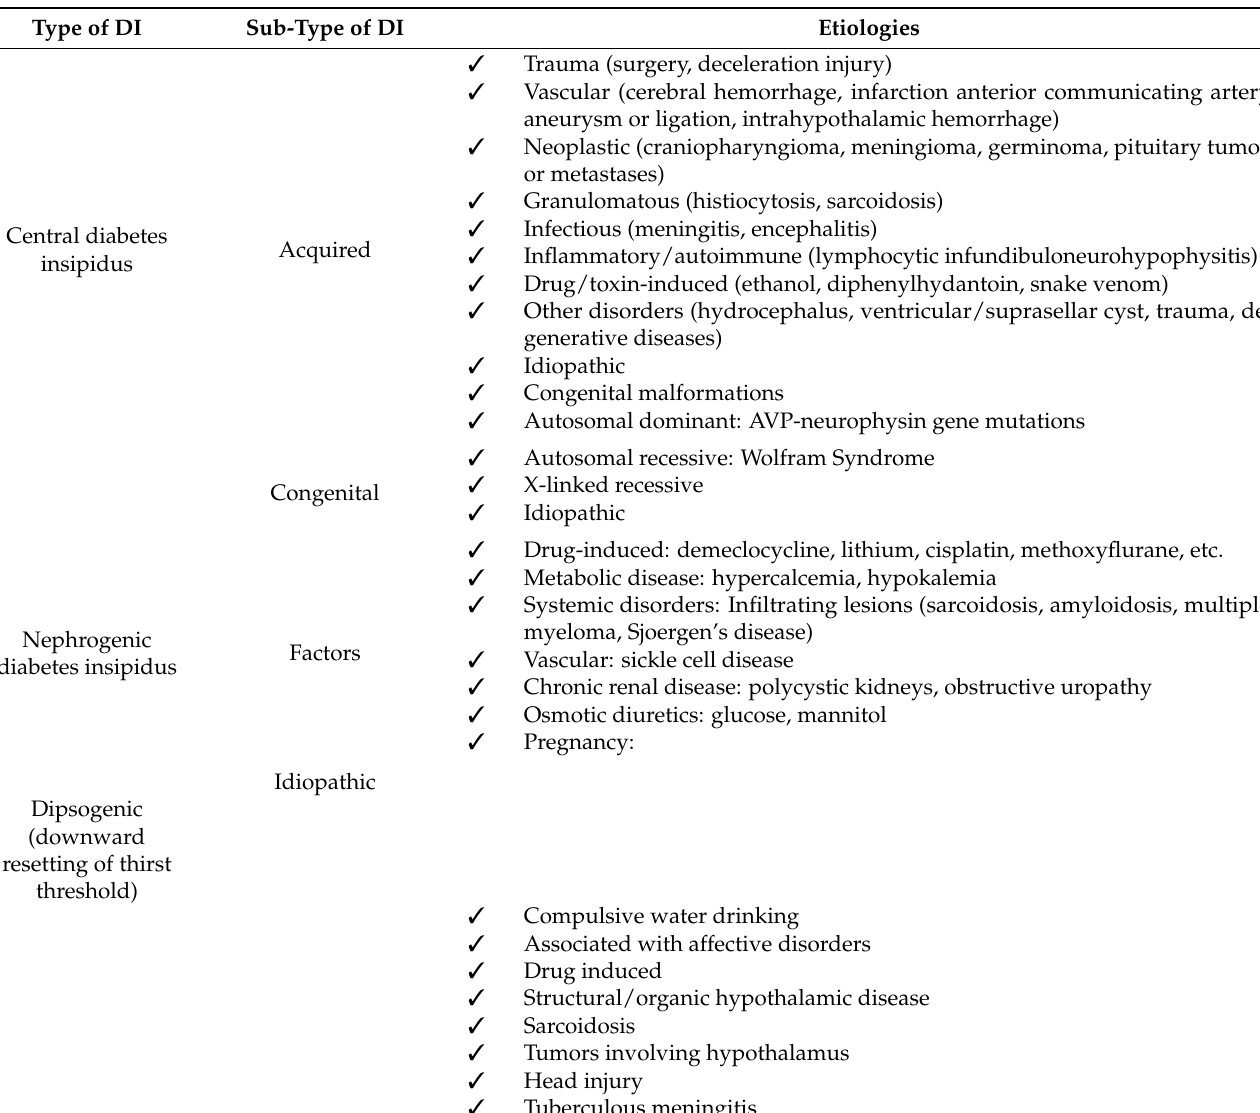
Table 1. Etiologies to consider in the differential diagnosis of polyuria polydipsia syndrome (PPS). DI: diabetes insipidus. Type of